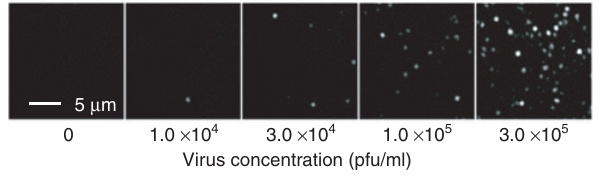
Figure 2: Example images from a total internal reflection microscope (TIRM) as individual human immunodeficiency virus particles are captured onto a functionalized coverglass surface. Adapted from